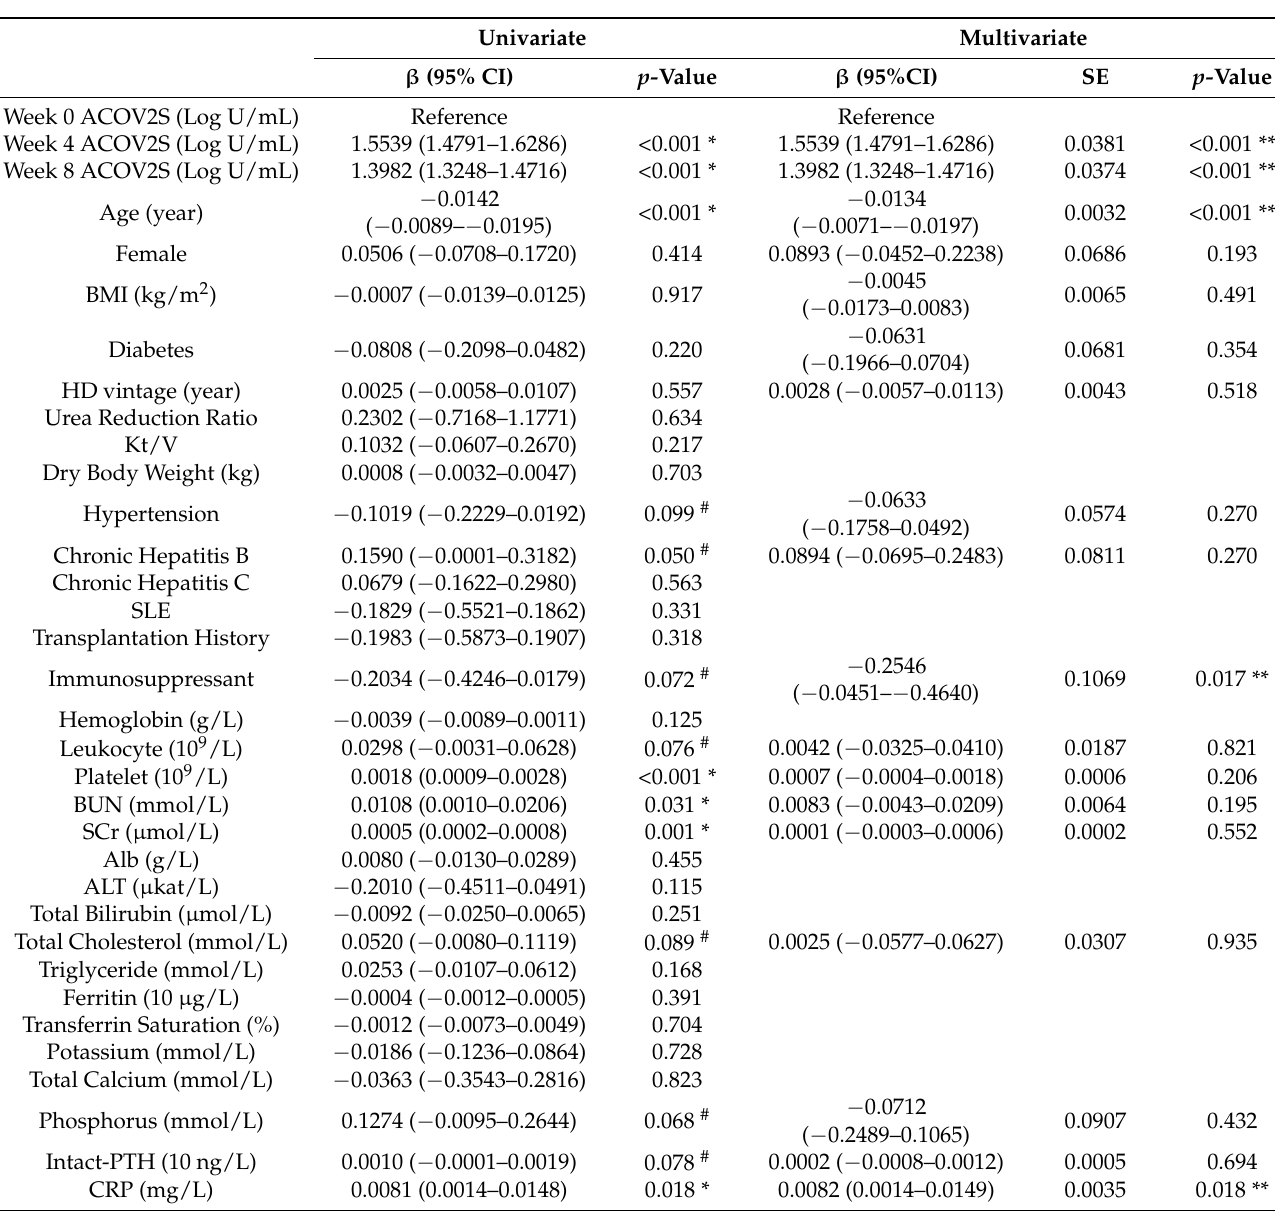
Table 3. Factors Associated with Humoral Responses after Second Dose of Vaccination in HD Patients. Univariate